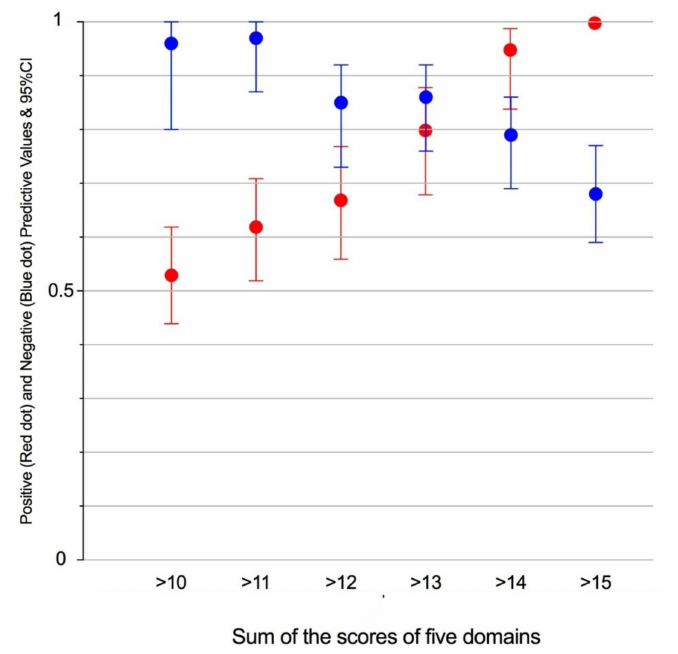
Figure 7. Negative ( blue ) and positive ( red ) predictive values (NPV and PPV) of increments in the BCCS.